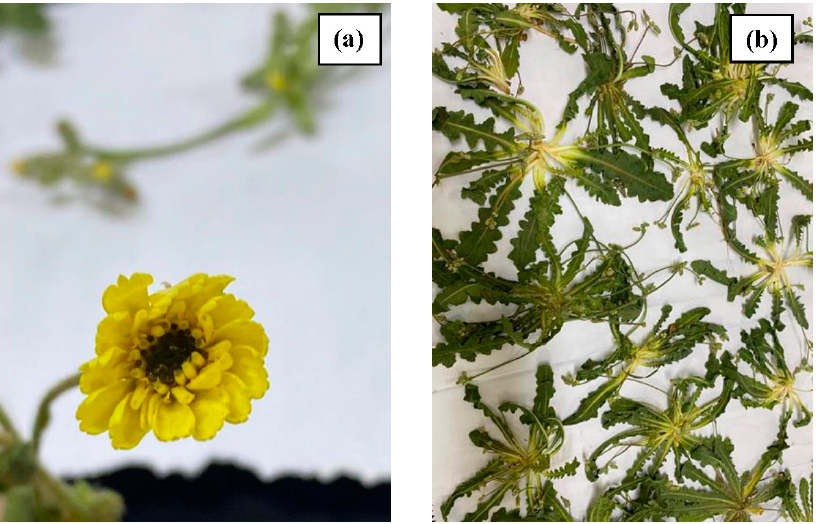
Figure 1. Photographs of Launaea capitata ; ( a ) the flower and ( b ) collected plant material used in the phytochemical study.